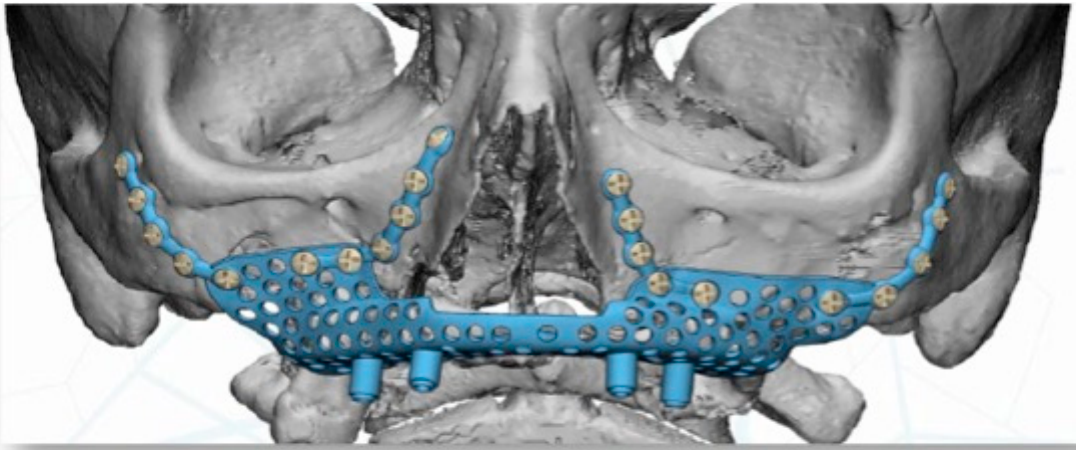
Figure 5. Virt ing for pl t of a customised prosthesis. Figure 5. Virtual planning for placement of a customised prosthesis.